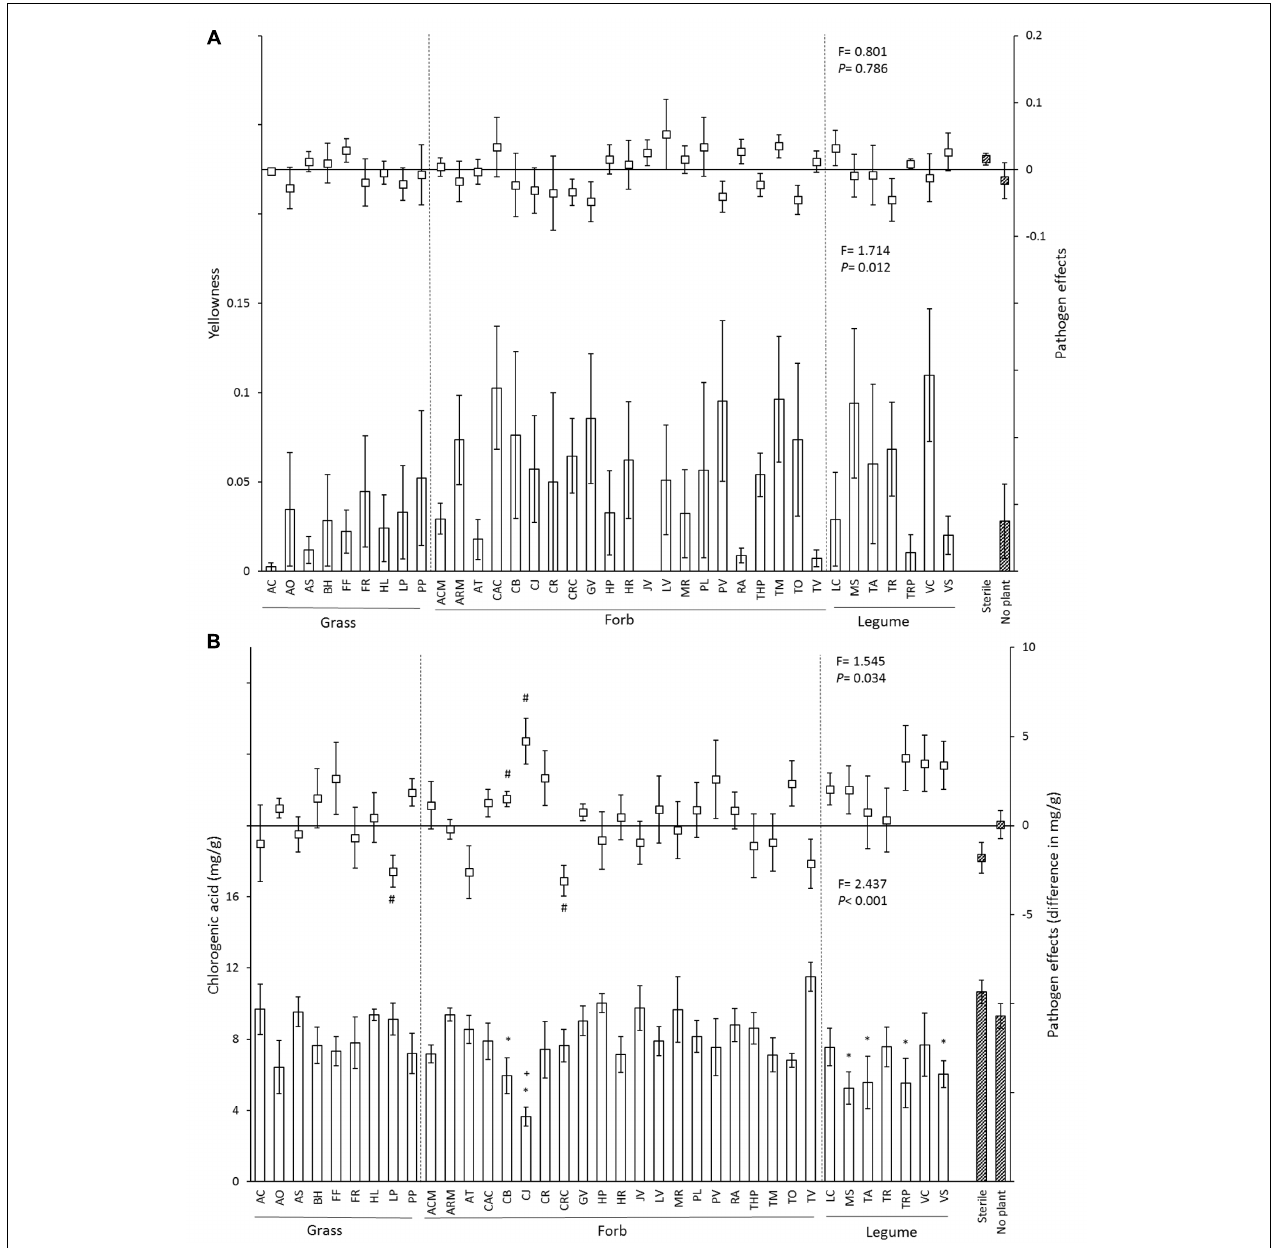
FIGURE 2 | Effects of 37 species-specific soil inocula, no plant inoculum and sterile soil on chrysanthemum yellowness (A) and leaf chlorogenic acid concentration (B) . In each figure, bars represent the mean ( ± SE) of each soil inoculum in control soil, and squares represent the pathogen effect (value in P. ultimum soil – value in non- Pythium inoculated soil). Striped bars indicate controls. “ ∗ ” Represents significant difference from the sterile soil ( P < 0.05). “+” Represents significant difference from the no plant soil inoculum ( P < 0.05), “#” represents significantly different from zero ( P < 0.05). Dashed lines separate soil inocula into different functional groups. Statistics presented in the lower part of each panel represent the effects of soil in control soil, and statistics presented in the upper part of each panel indicate the effects of soil inocula on the disease severity of chrysanthemum